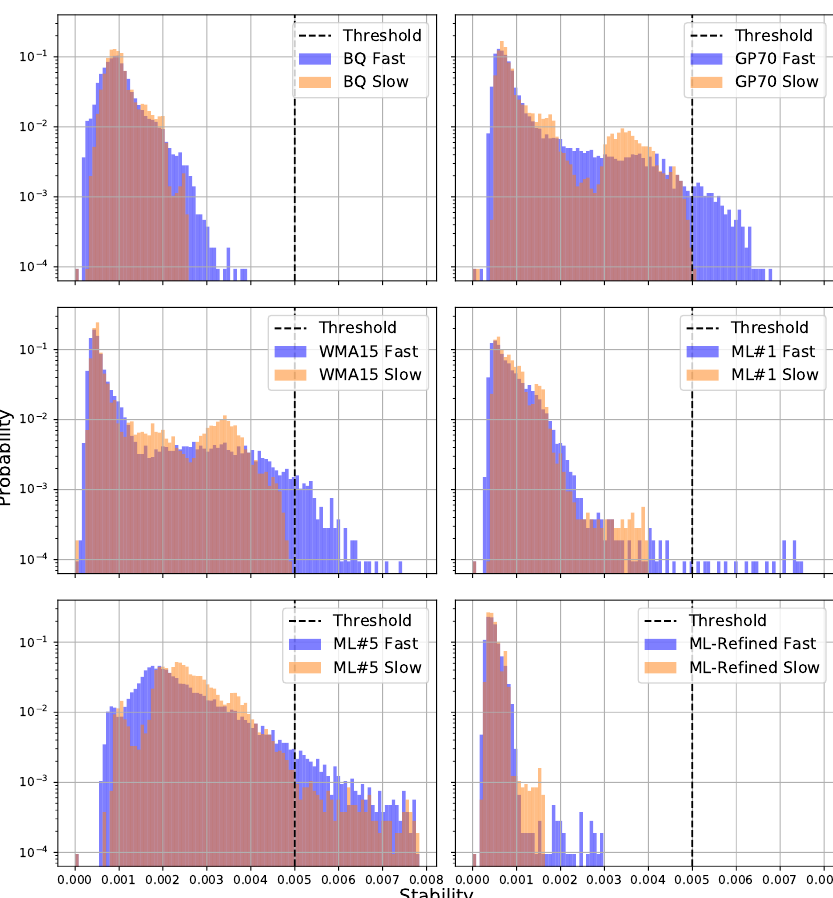
Figure 16. Probability distribution of the tune estimation stability. Obtained from Fill 6768, beam 1, horizontal plane using spectra from PRERAMP to FLATTOP. Slow and Fast correspond to stability measures having time constants of 10 s and 2 s respectively (Equation (7)). The threshold was chosen in the early design of the beam-based feedback systems and used in operation during the LHC Run 2. BQ was the original tune estimation algorithm used until the LHC Run 2; GP70 uses Gaussian Processes with a RBF kernel of length scale 70; WMA15 uses a Weighted Moving Average with a half-window length 15; ML#1 and ML#5 were the best performing DNN and CNN networks respectively trained with simulated spectra; ML-Refined had the same architecture as ML#1 and trained with refined